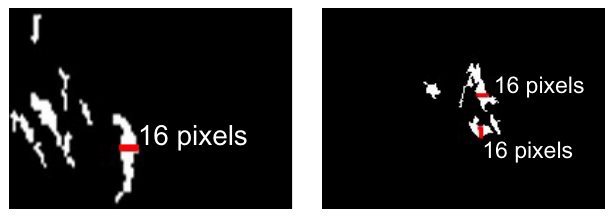
Fig. 7. Two examples of very small tumors. also be used for detecting which breast (right or left) contains tumors in an MRI.